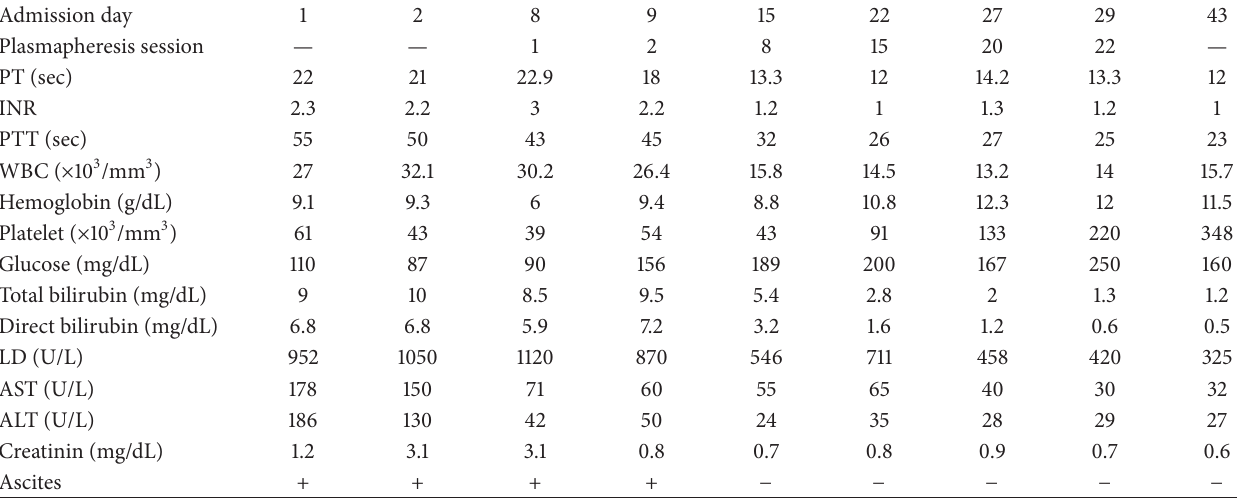
Table 1: Laboratory data of the first patient.